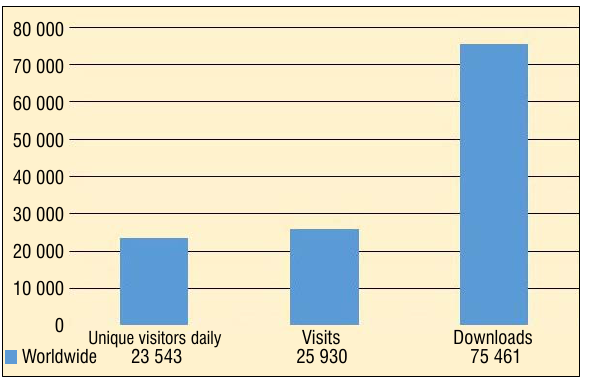
Figure 6: Capture of articles published in South African Journal of Libraries and Information Science between 2013 and 2016, expressed as a count of bookmarks, saves, etc.